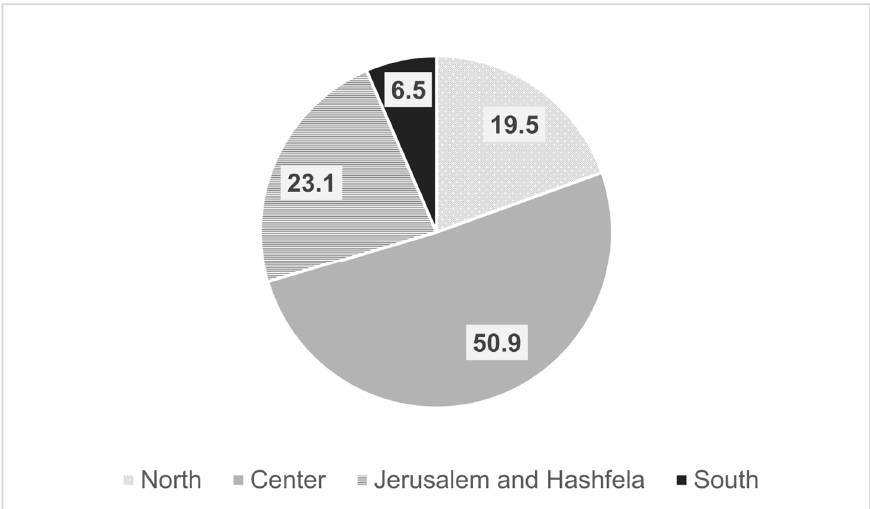
Figure 1. Geographic location of physicians’ workplace.